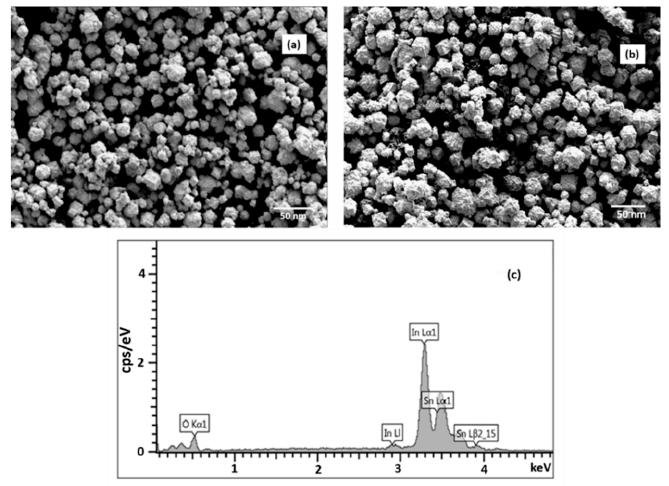
Figure 6. ( a ) SEM micrographs of ITO1 nanopowder synthesized at 10 kW, ( b ) SEM micrographs of ITO1 nanopowder synthesized at 20 kW, ( c ) Energy-dispersive X-ray Spectrum of ITO1 nanopowder synthesized at 10 kW. Reproduced with permission from Ref. [15]; published by IOP Publishing, 2018.